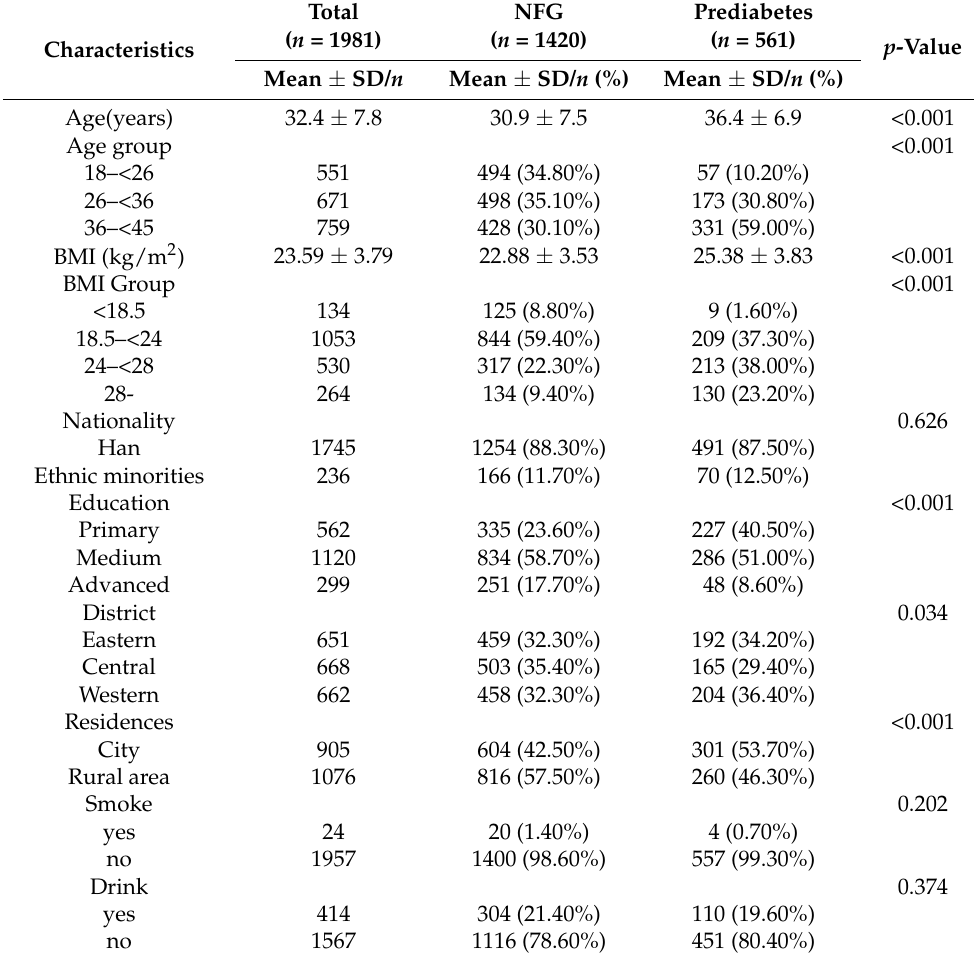
Table 1. Basic Characteristics of NFG and Prediabetes